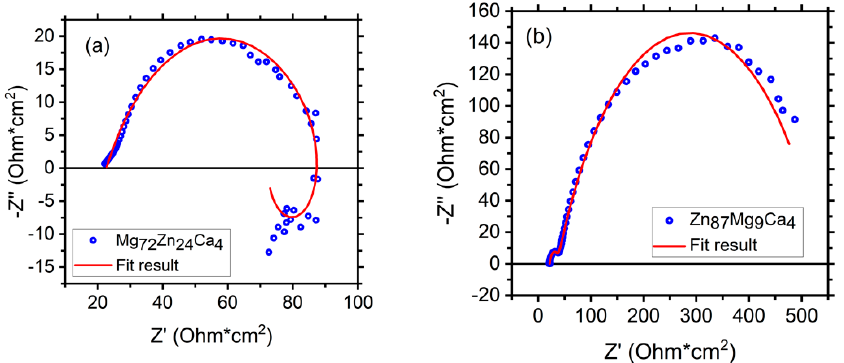
Figure 12. Polarization curves performed for the Zn 87 Mg 9 Ca 4 bulk material samples (blue curves) and Zn 87 Mg 9 Ca 4 ribbons (olive curves) in Ringer’s solution at 37 ° C, pH 7.2.